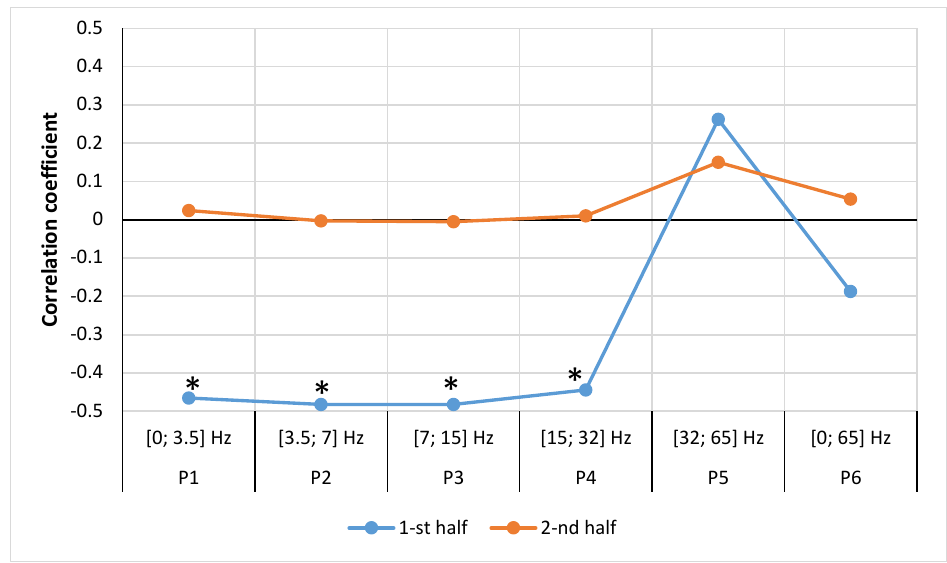
Figure 7. Correlation between number of women weekly cases of MI and mean magnetic power in different frequency ranges spanning a time of one week (data from LUHS, Cardiology clinic, 2016), * p <